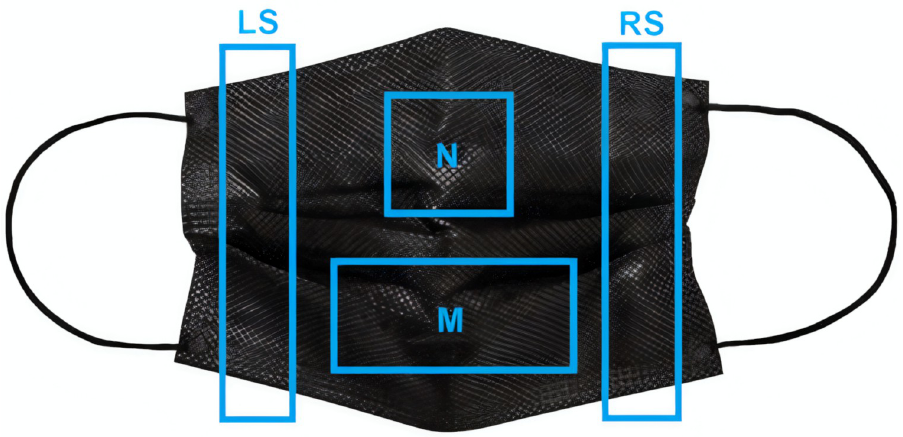
Fig 1. The scheme for cutting a mask. The areas enclosed within blue margins represent the areas cut from the mask. LS = Left Side, RS = Right Side, M = Mouth area, and N = Nose area.